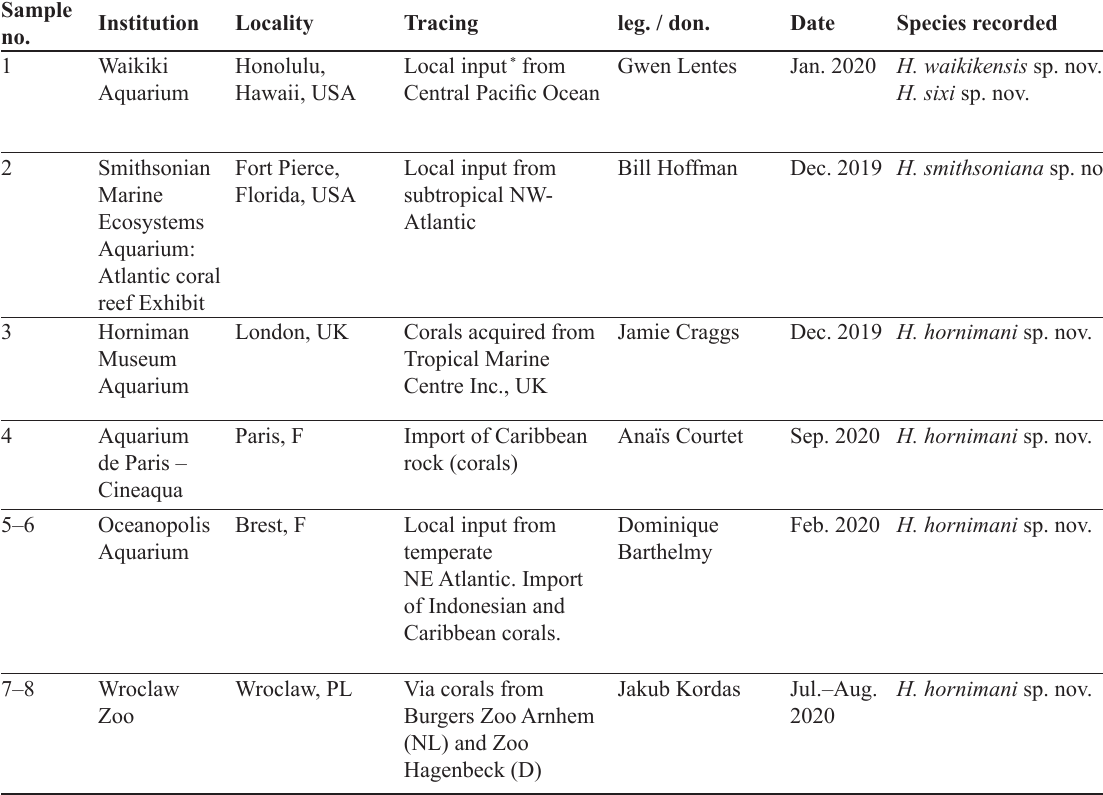
Table 1. Samples and data of Heteromysis S.I. Smith, 1873 obtained from aquarium